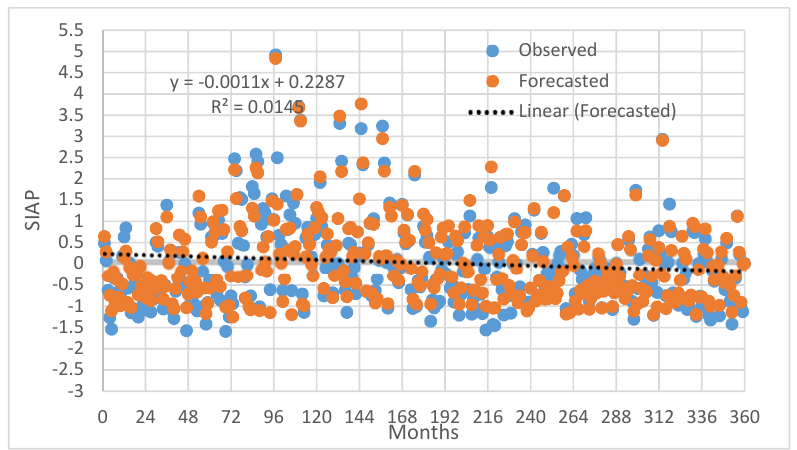
Figure 16. Scatter plot comparing observed and forecasted meteorological drought using W ‐ ANN models.